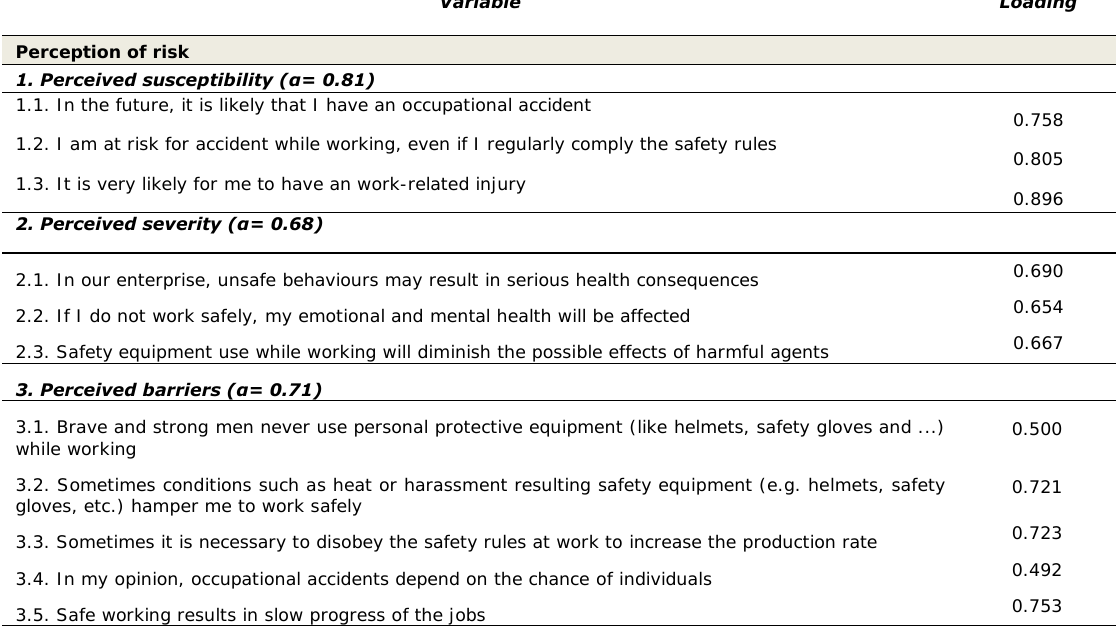
Table 1 . Factor loads and Cronbach's alpha values for each subscale of perception of risk and safety behaviour Variable